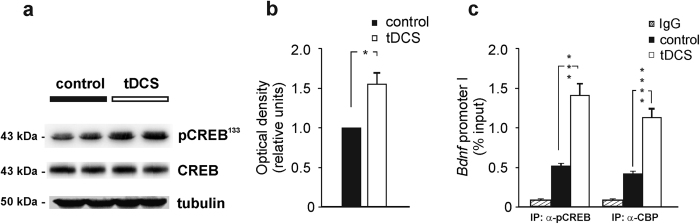
Activation of CREB/CBP pathway in the mouse hippocampus following anodal tDCS.(a) Representative Western blot analysis revealing increased phosphorylation of CREB at Ser133 by tDCS stimulation (see full scans in Supplementary Fig. 4). Expression levels of total CREB were unchanged. Experiments were performed in duplicate; samples were harvested from two independent experiments. (b) Band densitometry normalized to tubulin (P = 0.015, hippocampi from tDCS-mice vs. control [n = 5 tDCS-mice; n = 3 controls], unpaired Student’s t-test). (c) Results from ChIP assays performed on hippocampal extracts (n = 3 control mice and n = 3 tDCS-mice) showed that tDCS increased CREB binding (P < 0.0001, Mann-Whitney test) and CBP recruitment to Bdnf promoter I (P < 0.00001, Mann-Whitney test). Bdnf promoter I fragments were amplified from anti-CBP and anti-pCREB immunoprecipitated DNA or from the total chromatin input (TI) as quantitative control. PCR samples were run and analyzed in triplicate; data were obtained from two independent experiments. Data are expressed as percentage of input. Data are expressed as mean ± s.e.m. *P < 0.05; ***P < 0.0001; ****P < 0.00001.